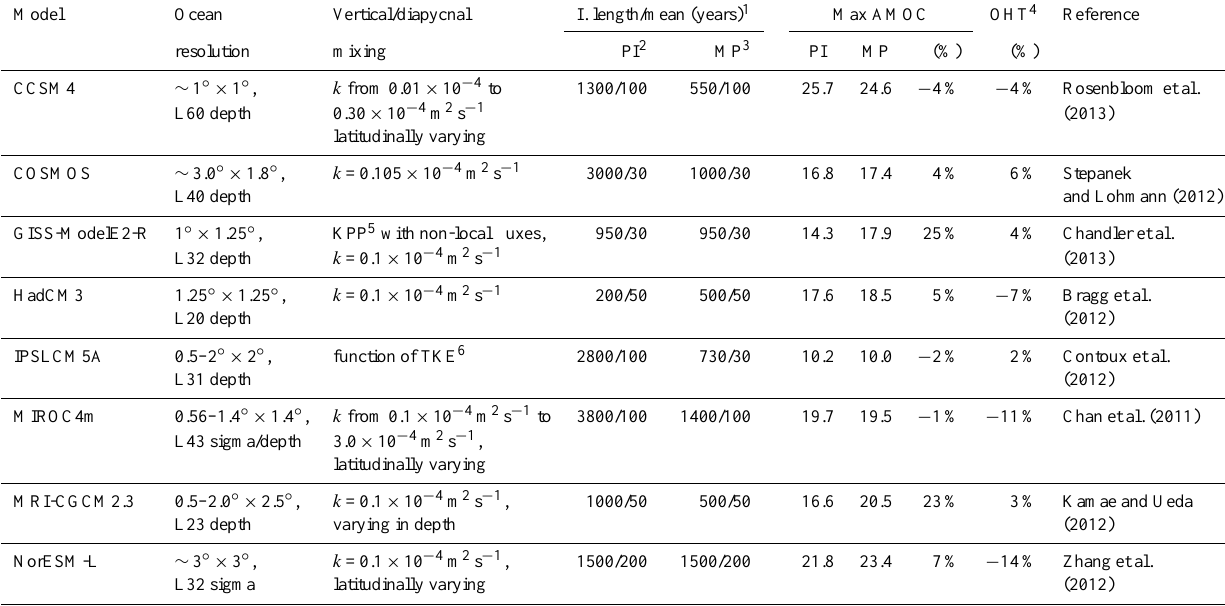
Table 1. Comparison of the eight models that have performed coupled simulations in the PlioMIP. Model Ocean Vertical/diapycnal resolution mixing PI 2 MP 3